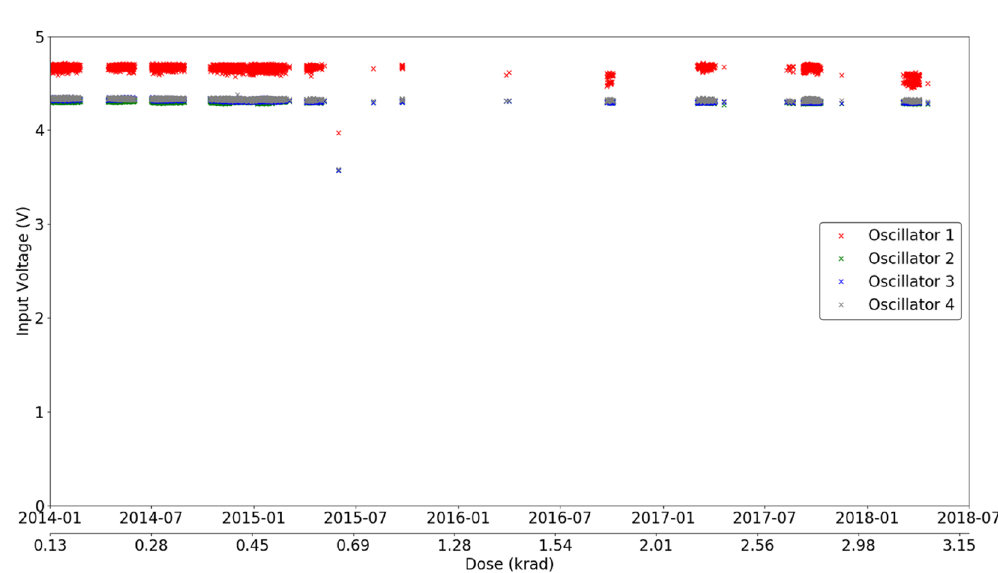
Figure 8. CCTB Input voltage of all oscillators as a function of time and dose for temperatures between 22 and 25